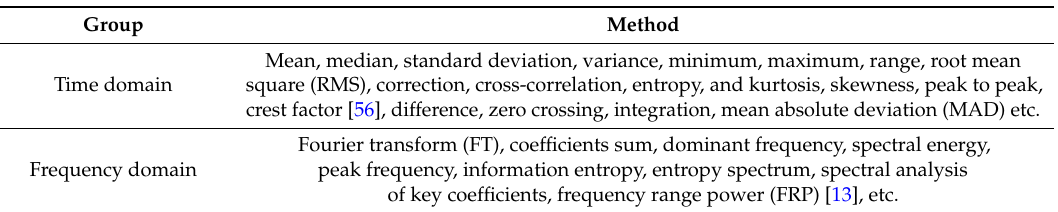
Table 4. Summary of features for pre-processing